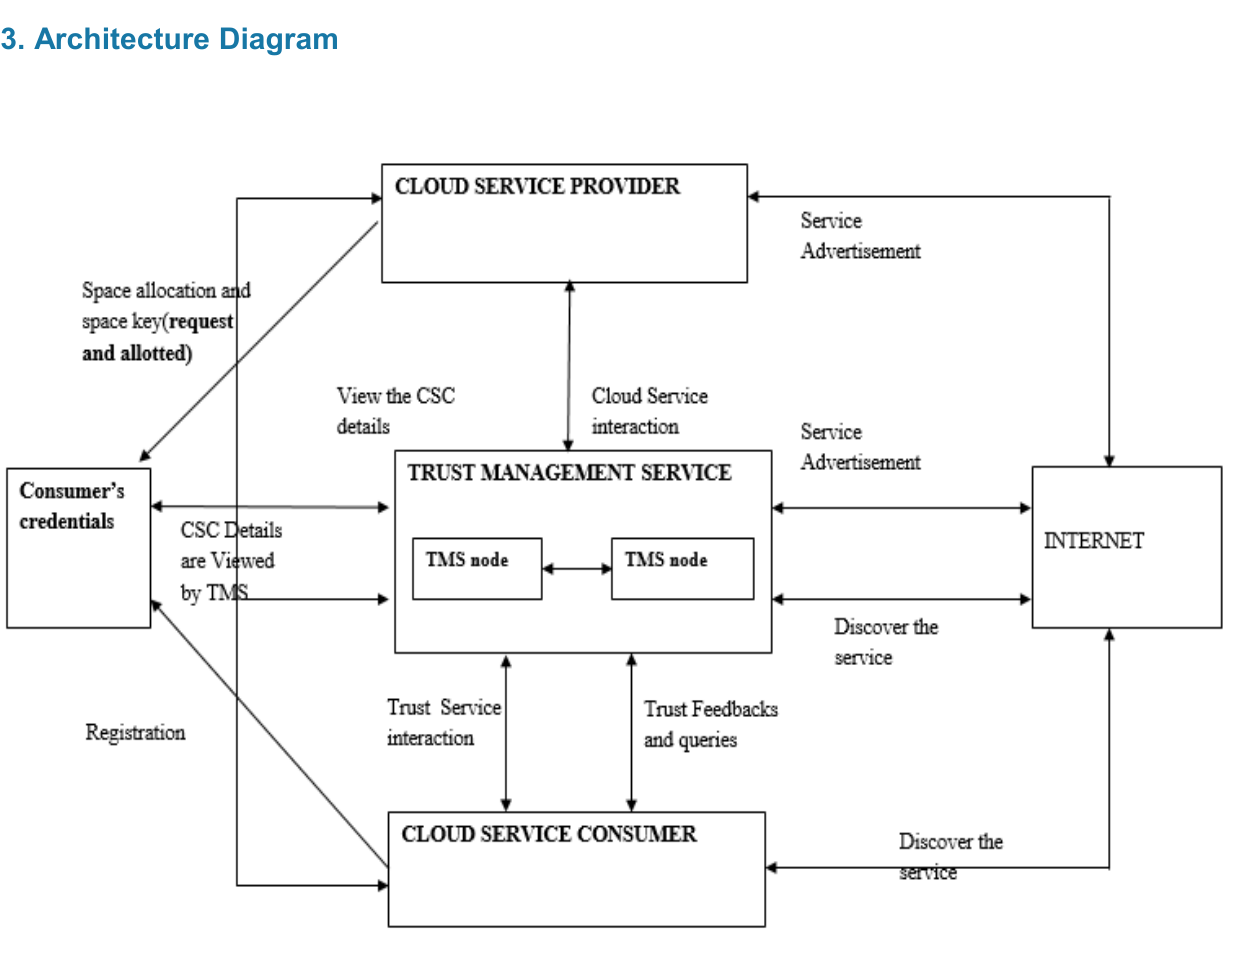
Figure 2 . Trust Management